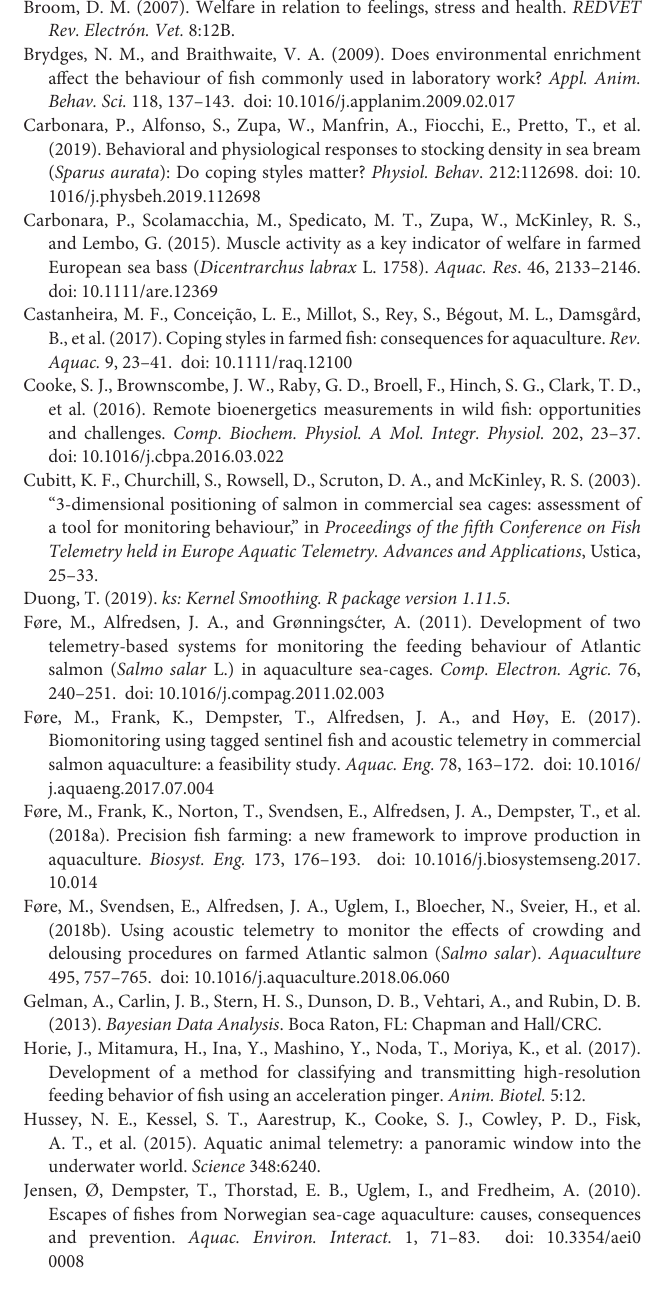
calculated position and the known positions (HDOP: Heatpoint Deviation of Optimal Position; in meters). The heatmap was generated by the manufacturers (PinPoint, Thelma Biotel) as follows: (i) a wide rectangular matrix (100 × 100 points) was made around the receiver grid (50 cm between each point); (ii) For every grid point, the signal travel time to each receiver was calculated. Thereafter, a random time error of + -1 ms-1 was added to the calculated times of arrival; (iii) the simulated travel times were used to create the time difference of arrival equations and calculate the positions; (iv) error sensitivity running a simulation 20 times for every grid point (new random error for each turn); (v) the deviation between the calculated positions and known positions were stored in a new solutions matrix and plotted in the heatmap